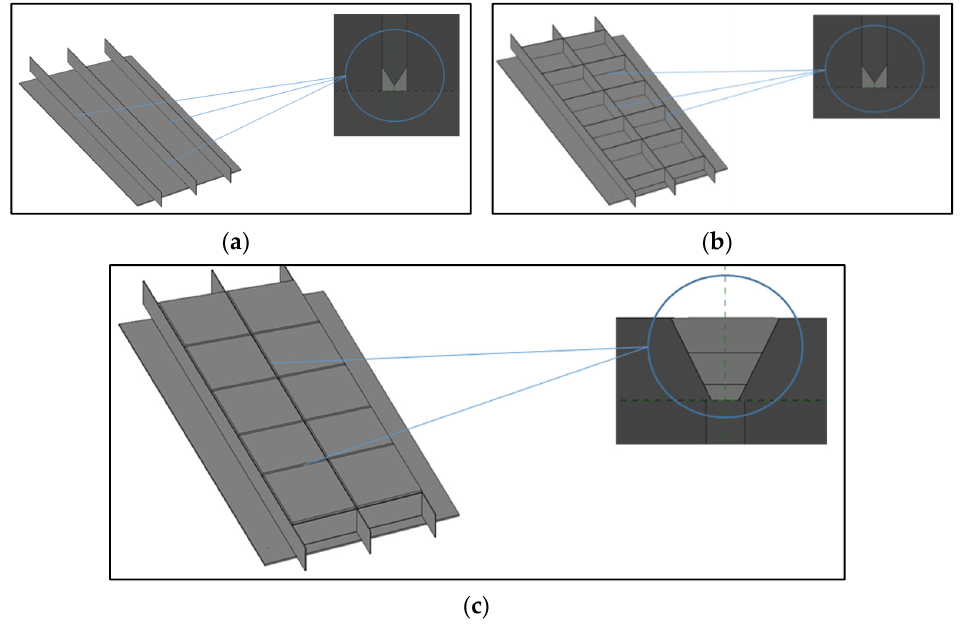
Figure 16. ( a ) Vertical stiffener welding; ( b ) Welding of horizontal stiffening elements; ( c ) Welding of external panels.